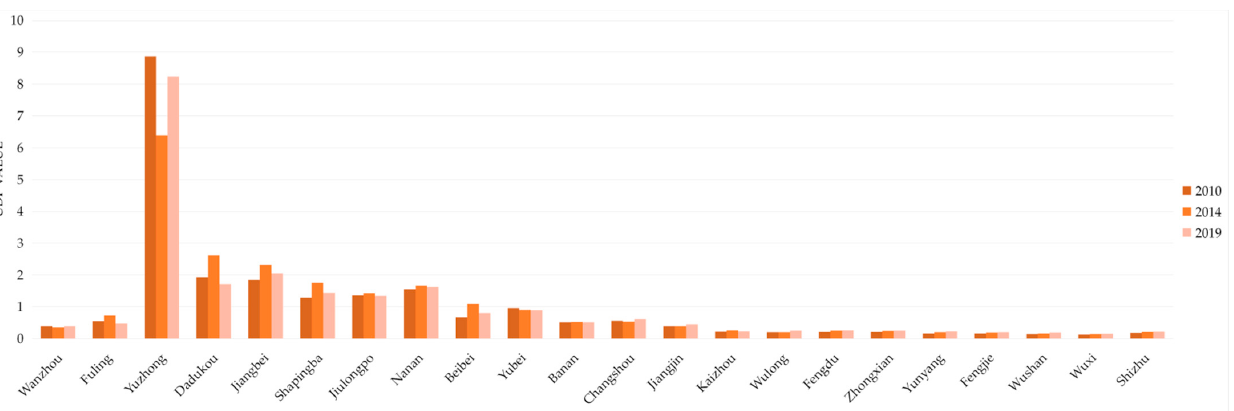
Figure 6. Changes of UDI in the Three Gorges Reservoir Area (Chongqing section). Sources: Calculation results of UDI in the Three Gorges Reservoir Area (Chongqing section).